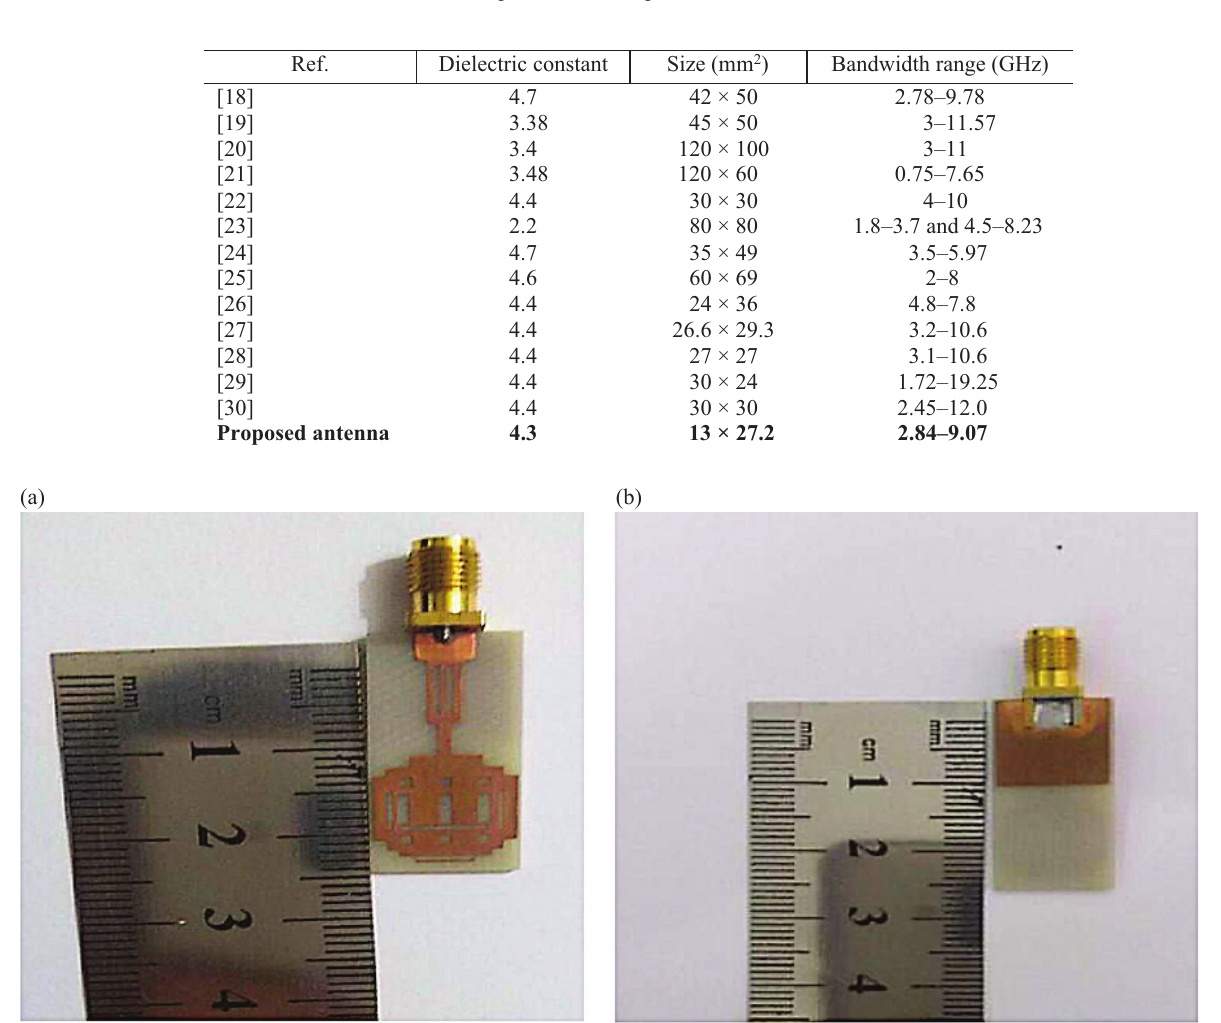
Fig. 10. The prototype of the designed UWB antenna: top view (a) and bottom view